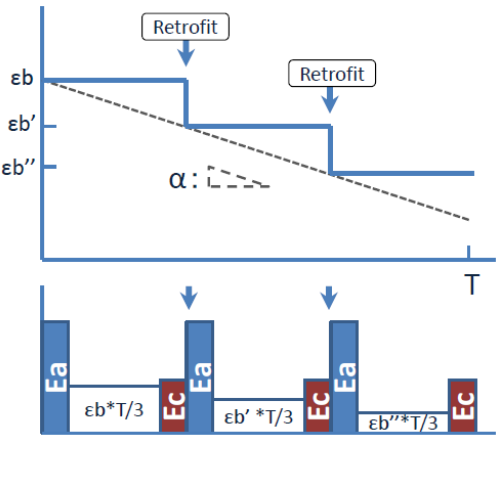
Figure 2. Outline of evaluation concept.